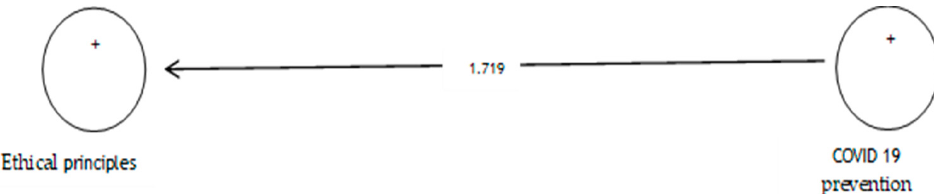
Figure 4. The model of the first hypothesis includes factor load coefficients.